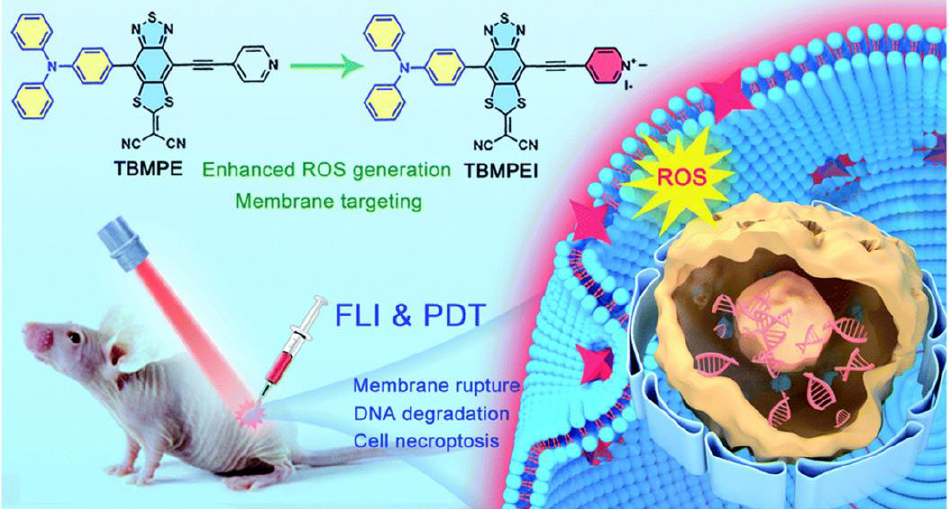
Figure 2. Schematic illustration of TBMPEI with cell-membrane-targeting function. Reprinted with permission from Ref. [41]. Copyright 2022 Royal Society of Chemistry.